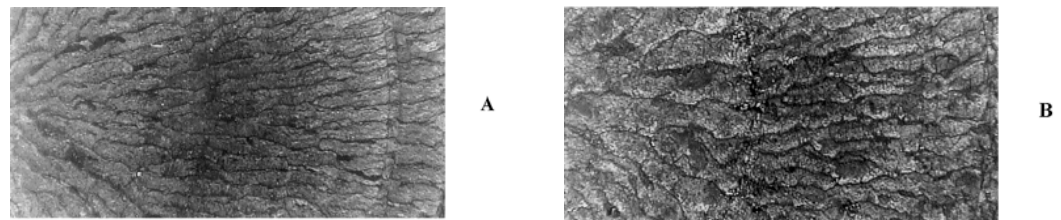
Figure 27. Abrasion pattern of SBR samples (normal load = 25 N): ( A ) without GTR, ( B ) with GTR (particle size = 420–600 μ m; content = 30 phr) (reproduced with permission from [119]).